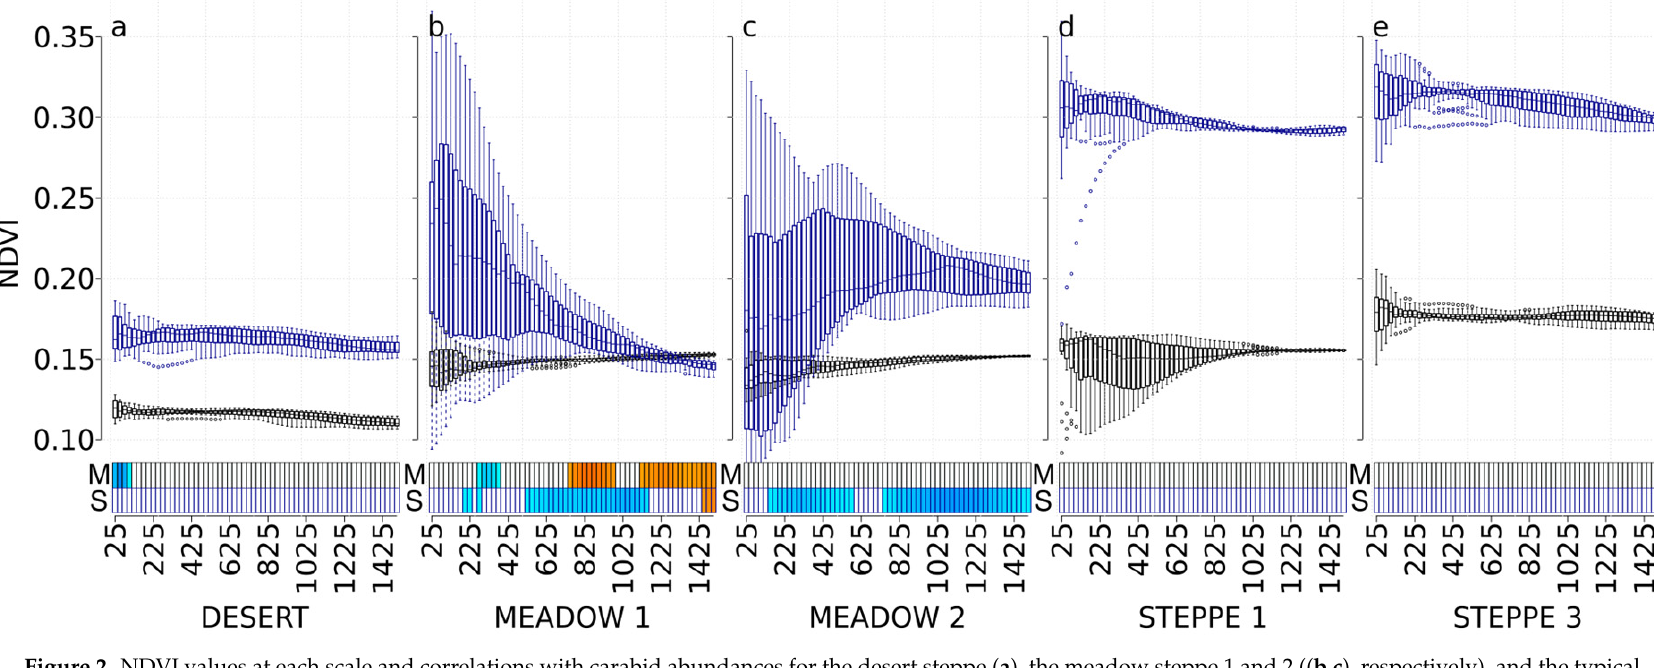
Figure 2. NDVI values at each scale and correlations with carabid abundances for the desert steppe ( a ), the meadow steppe 1 and 2 (( b , c ), respectively), and the typical steppe 1 and 3 (( d , e ), respectively). Boxplots represent the NDVI values with a black border for the May 2017 Landsat image and with a dark-blue border for the September 2017 Landsat image. For each boxplot, a di ff erent background color indicates a significant di ff erence in NDVI values using the Tukey test. The x -axis presents the di ff erent spatial scales used in the analysis (cardinal distances in meters representing circle radius ranging from 25 to 1500 m). The correlation with carabid abundances is represented with rectangles at the bottom of each graph, using a gradient from blue to red (dark blue corresponds to a negative correlation, dark red corresponds to a positive correlation, and white corresponds to no significant correlation).